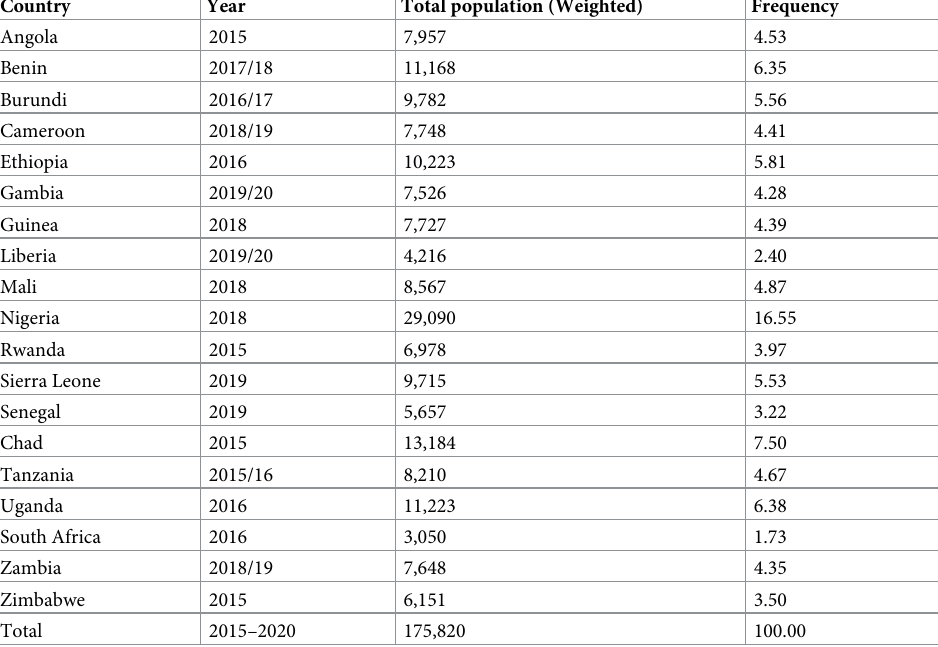
Table 1. Sample size in each country, study year, and total sample